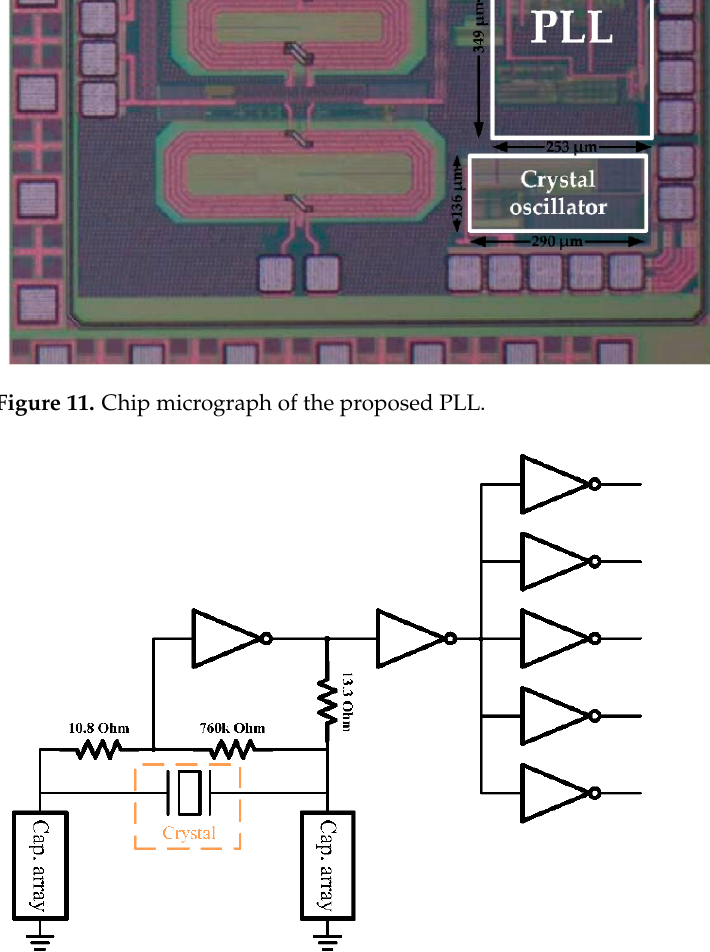
Figure 12. The proposed crystal oscillator scheme.